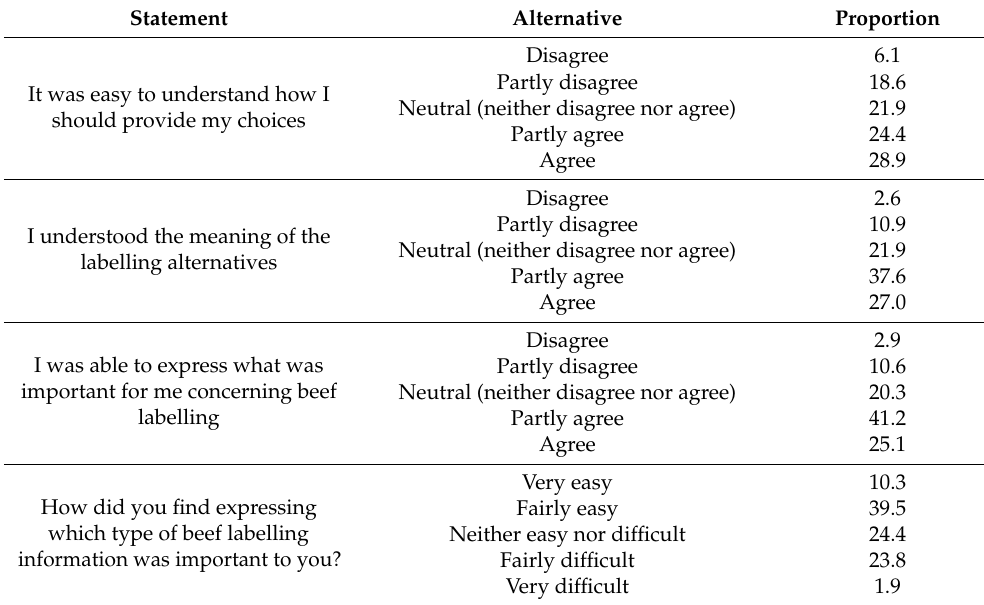
Table 4. Respondents’ evaluation of the response formats as